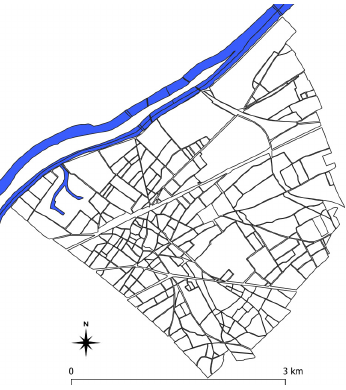
Figure 1. Census as statistical data: Focus on Nanterre and its “ˆılots” in 1954.